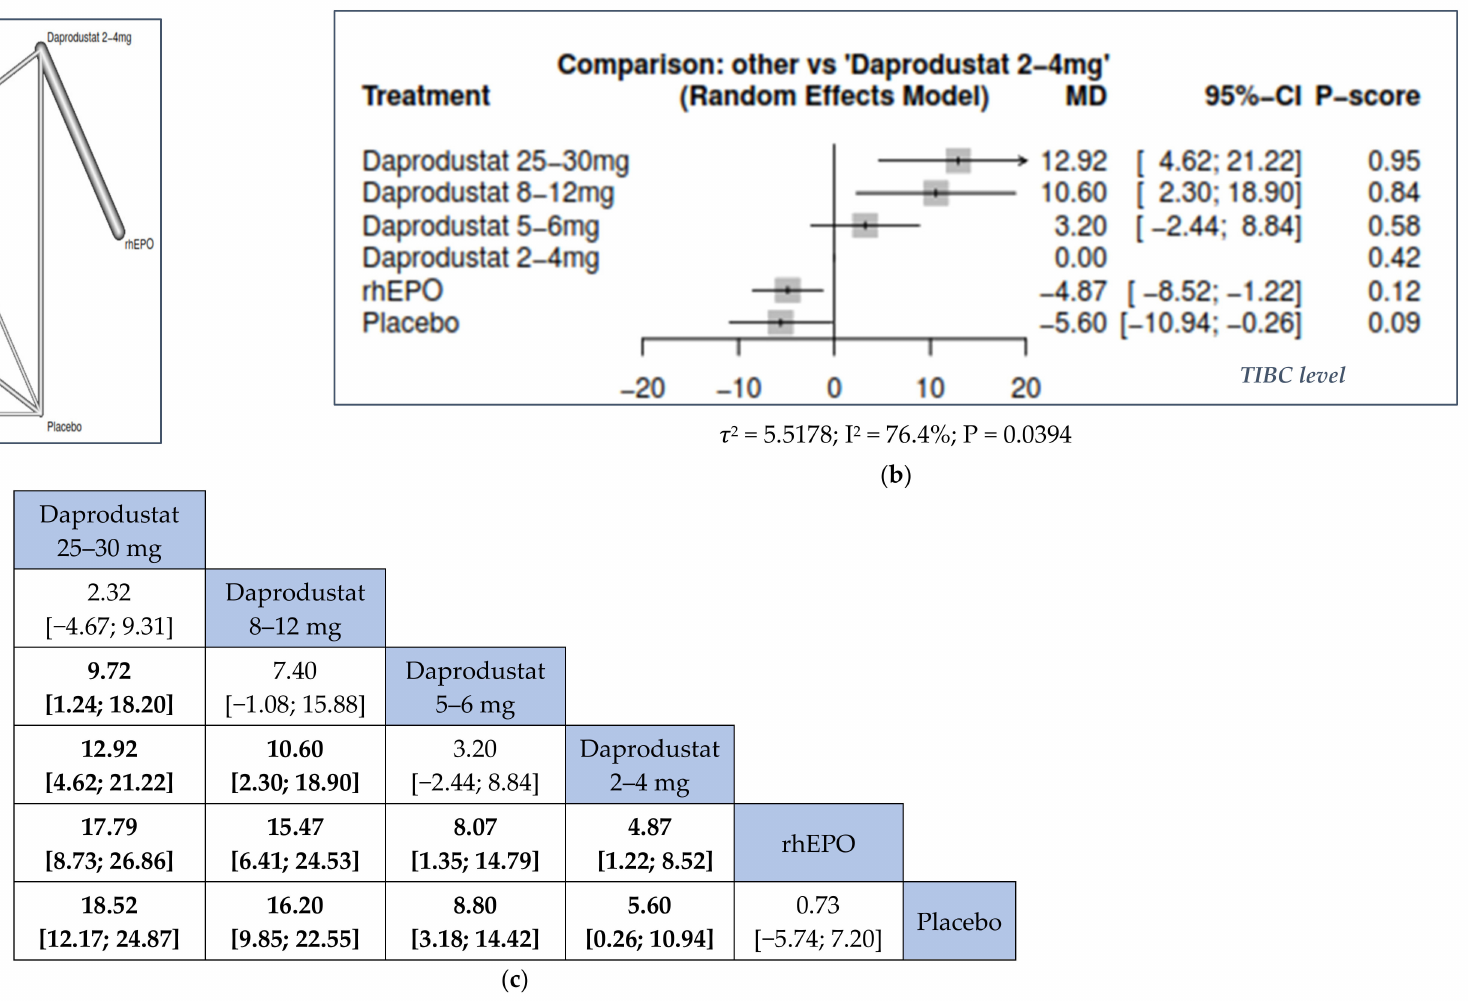
Figure 5. Network meta-analysis results of total iron-binding capacity (TIBC). ( a ) Network graph showing direct evidence between the assessed interventions. ( b ) A forest plot was generated by comparing all interventions with “placebo”; P-score was used for ranking. ( c ) The league table represents the network meta-analysis estimates for all interventions comparisons; the results are the mean difference (MD) with 95% CI, bold items are statistically